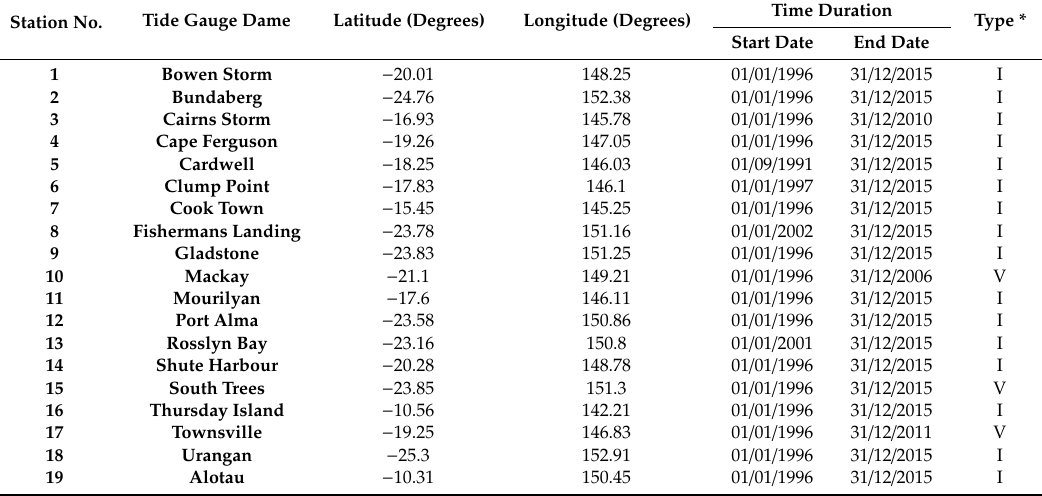
Table 2. The geographic position and period of observation records for coastal tide gauges. Station